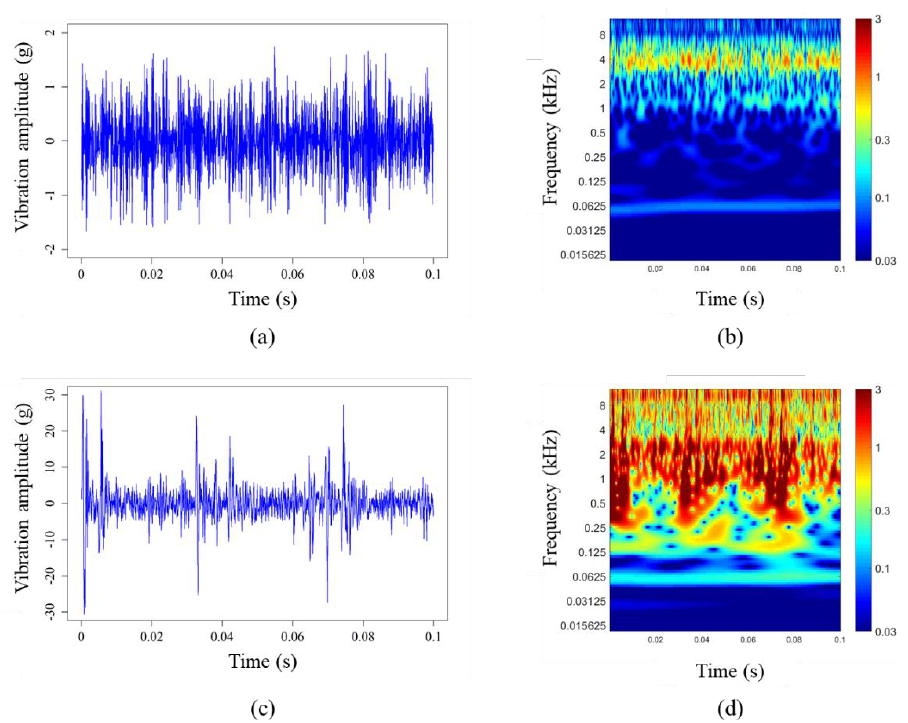
Figure 6. Time domain vibration signal and contour plot of wavelet power spectrum of bearing 1_1: ( a ) raw signal (normal condition); ( b ) wavelet power spectrum (normal condition); ( c ) raw signal (fault condition); ( d ) wavelet power spectrum (fault condition).